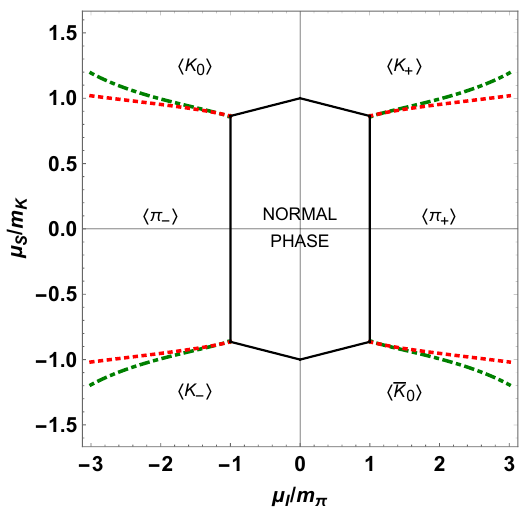
Figure 2 . Phase diagram in the (cid:22) I { (cid:22) S plane at T = 0. Solid lines represent second-order transitions while the red dashed lines are the tree level (cid:12)rst-order transitions and the green dot-dashed lines are the NLO (cid:12)rst-order transitions. The normal phase has vanishing meson condensates and the meson condensate that becomes non-zero is indicated in each